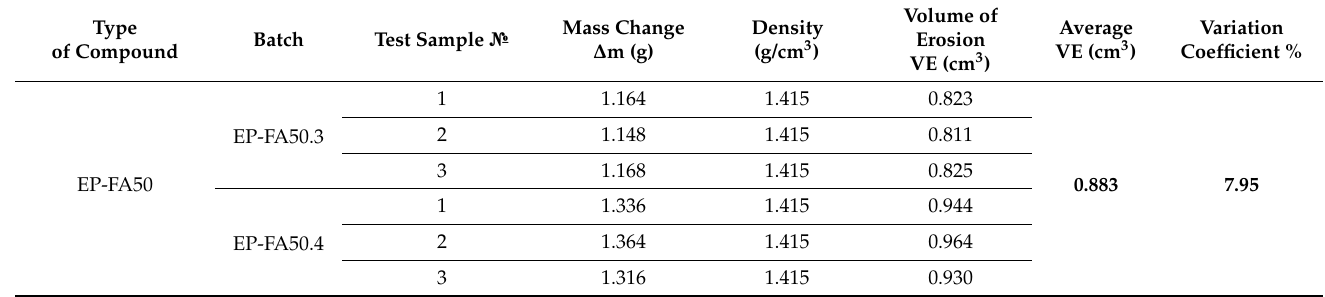
Table A18. Wear of filled epoxy binder (EP-FA50) at 180 ◦ C at an impingement angle of 45 ◦ .